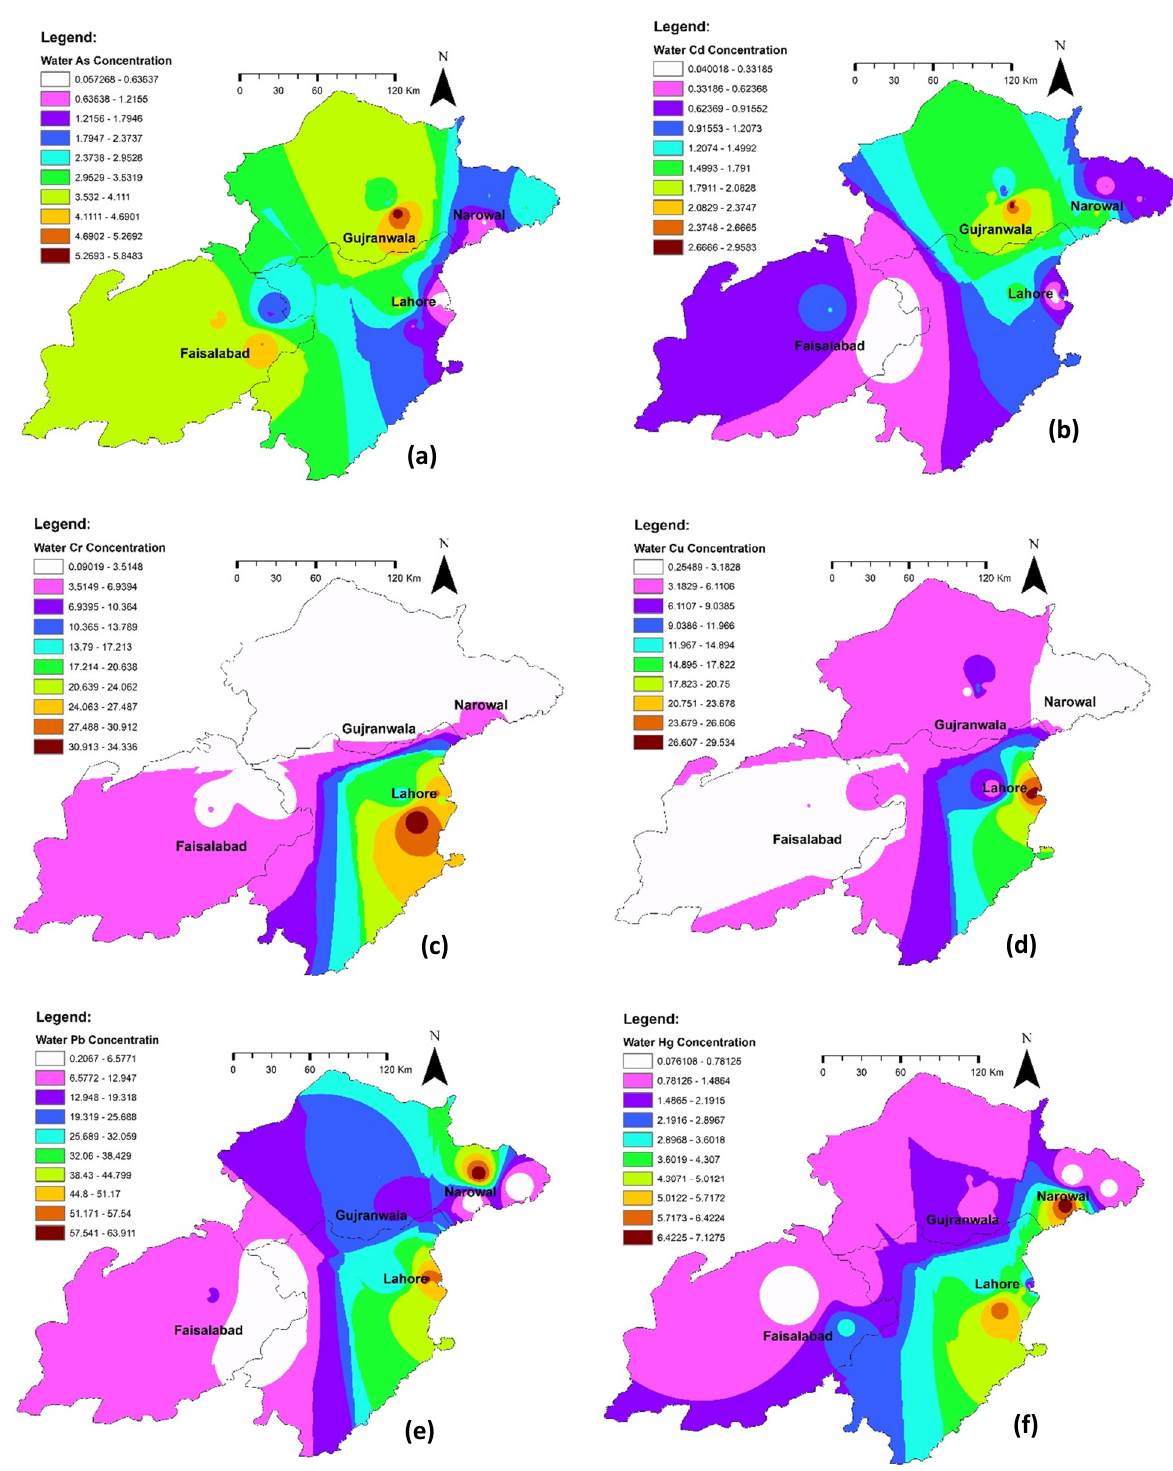
Figure 3. Spatial distribution maps of various metals and metalloids concentrations in irrigation water samples. Variation in color indicates the levels of metals and metalloid (mg L − 1 ) concentrations in water samples from sampling points; ( a ) arsenic contents; ( b ) cadmium contents; ( c ) chromium contents; ( d ) copper contents; ( e ) lead contents;( f ) mercury contents